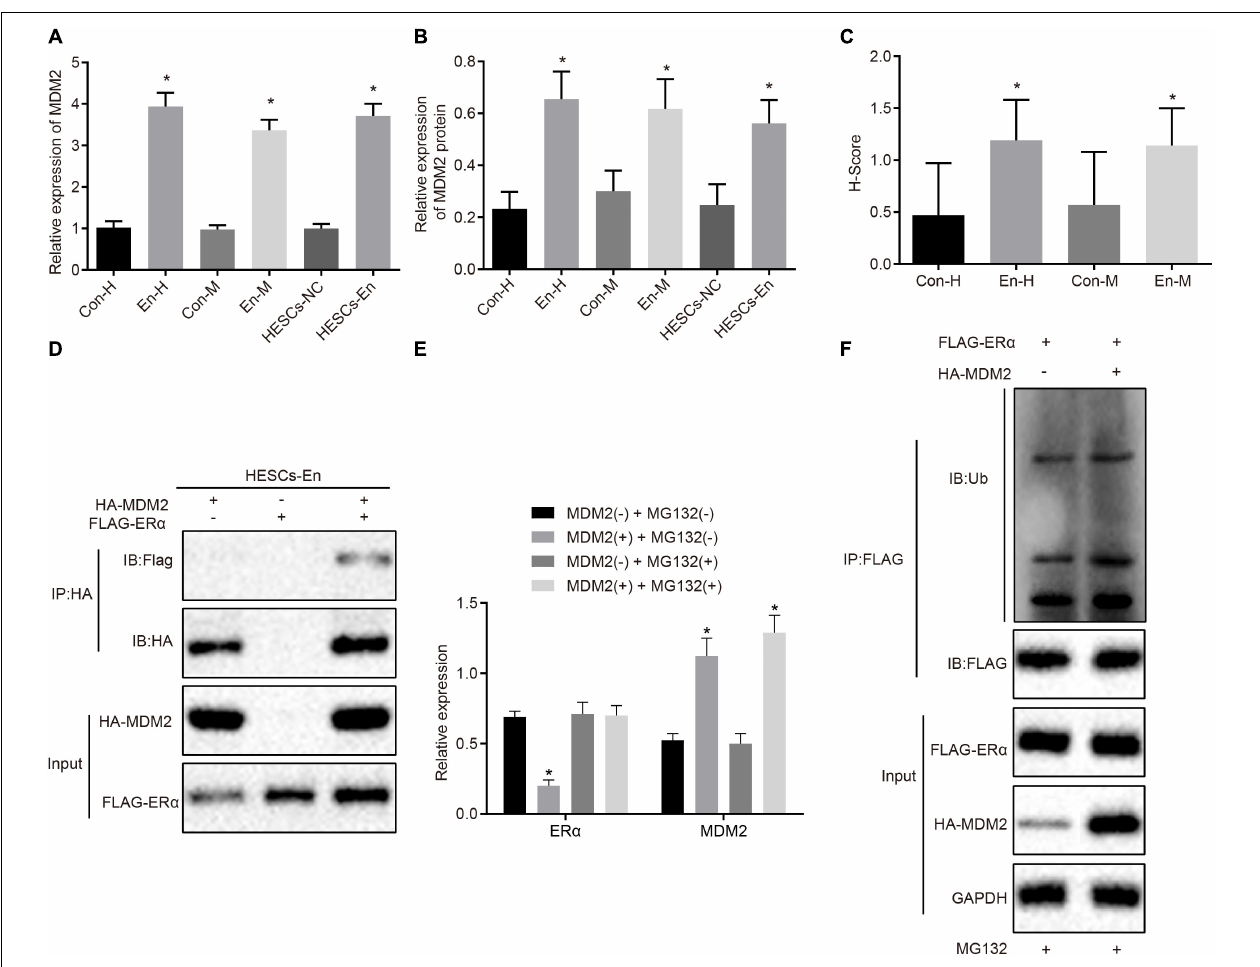
FIGURE 5 | MDM2 decreases the transcriptional activity of ER α by degradation in HESCs in vitro . (A) The mRNA expression of MDM2 in human and mouse endometriosis/normal tissues and HESCs determined by RT-qPCR. (B) The protein expression of MDM2 in human and mouse endometriosis/normal tissues and HESCs determined by Western blot analysis. (C) The statistical analysis of immunohistochemical staining of MDM2 in human and mouse endometriosis/normal tissues. (D) The interaction between MDM2 and ER α by Co-IP assay. (E) The protein expression of ER α and MDM2 in the presence or absence of MDM2 by Western blot analysis. (F) Ubiquitin of ER α in the presence or absence of MDM2 by ubiquitin test. Comparisons between two groups were analyzed using independent sample t -test. * p < 0.05 vs. human or mouse normal tissues, HESCs-NC cells or MG132-treated cells without MDM2. n = 78 for human normal tissues. n = 91 for human endometriosis tissues. n = 14 for mouse endometriosis/normal tissues. Cell experiments were conducted in